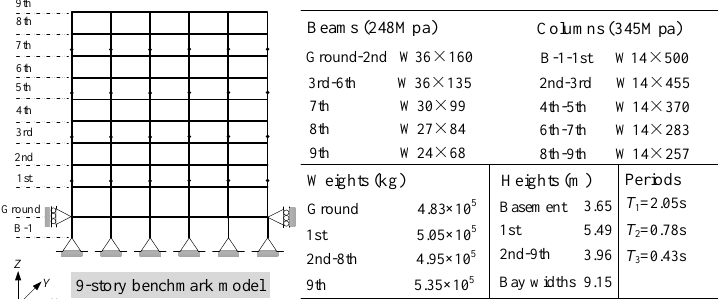
248 MPa for the beams and 345 MPa for the columns. The columns were pin-connected to the base. The tributary seismic mass of the chosen lateral resisting frame was 4.50 × 10 6 kg.